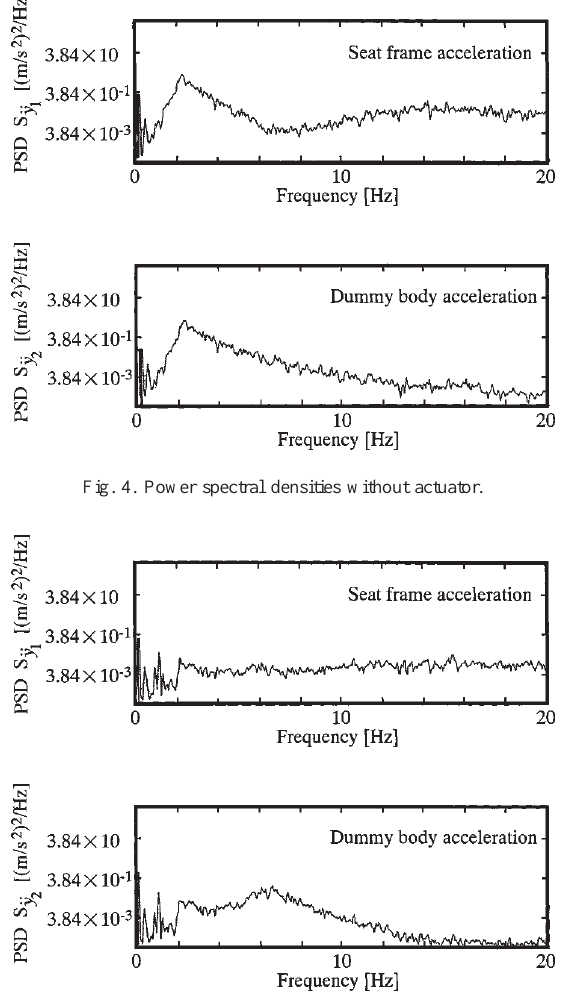
Fig. 5. Power spectral densities with actuator.